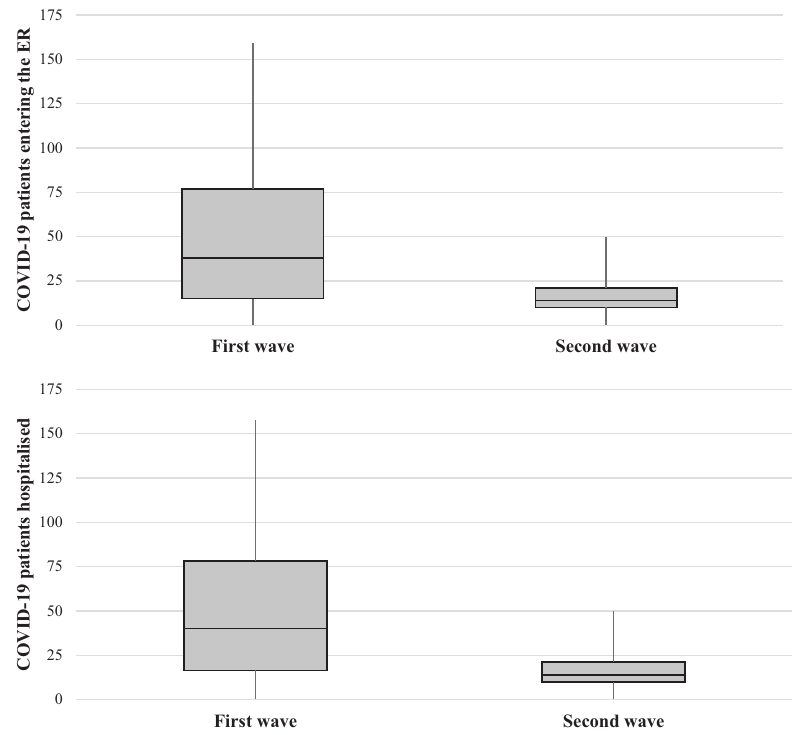
Figure 2. Distribution of the number of hospital admissions per day during the first and second